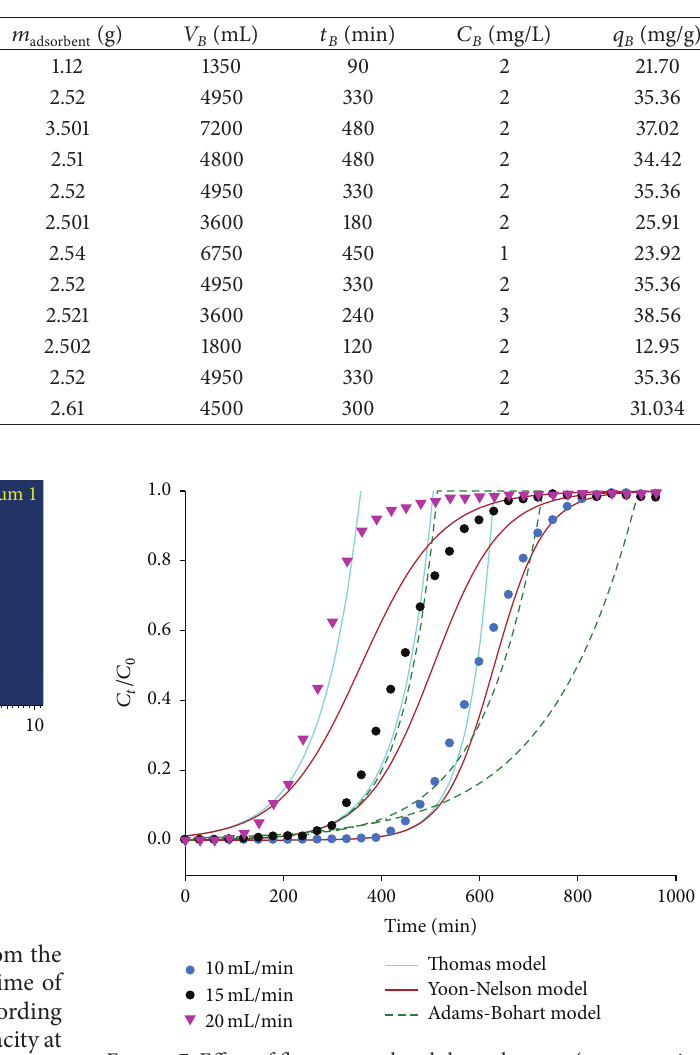
Table 4. Values of 𝑘 AB decrease with increasing concentration and flow rate whereas they increase with increasing bed depth. The values of 𝑅 2 fluctuate from 0.32 to 0.90 which is not a good fitting with the experimental breakthrough